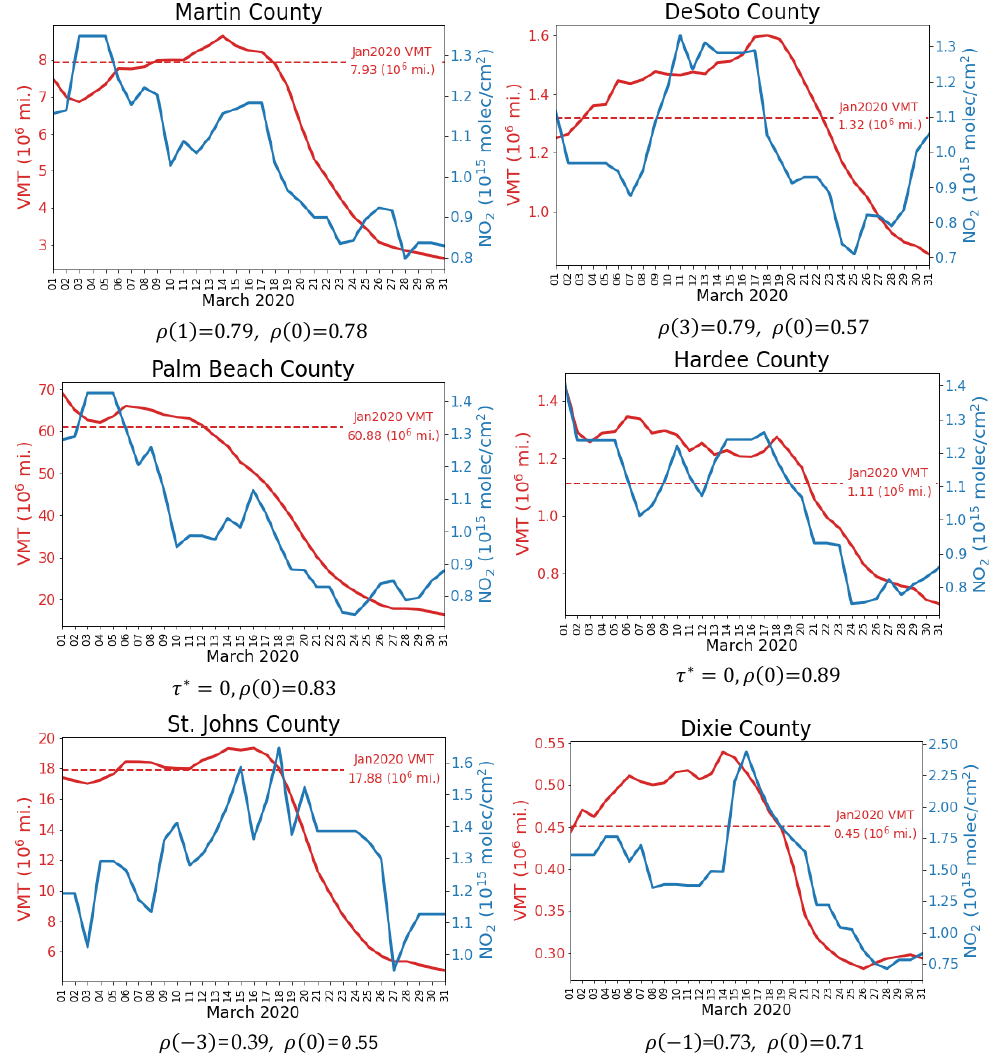
Figure 8. Di ff erent time lags ( τ ∗ ) and correlation ρ ( τ ∗ ) between 7-day moving averages of VMT and NO 2 in counties with higher median income (left column > $55,000) and lower median income (right column < $40,000)